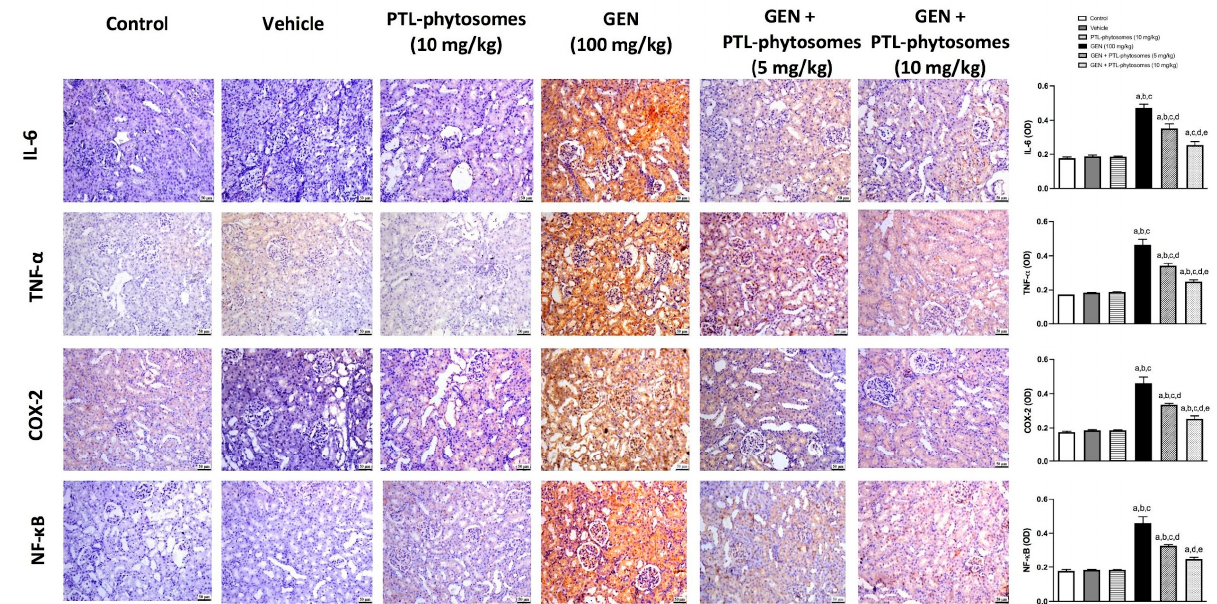
Figure 9. PTL-phytosomes reduced the expression of IL-6, TNF- α , COX-2, and NF- κ B (p65) in GEN- treated rats. The immunohistochemical staining section was quantified as OD. Data are expressed as Mean ± SD ( n = 6). a: significant when compared to control at p < 0.05; b: significant when compared to vehicle at p < 0.05; c: significant when compared to PTL-phytosomes at p < 0.05; d: significant when compared to GEN alone at p < 0.05; e: significant when compared to GEN + PTL-phytosomes (5 mg/kg) at p < 0.05. Scale bar, 50 μ m.